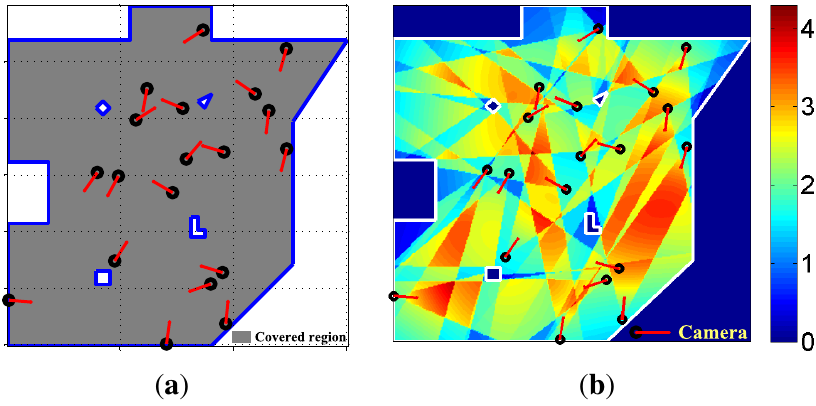
Figure 3. Layout results on the irregular square scene without critical regions. (a) Coverage. (b) Observation quality